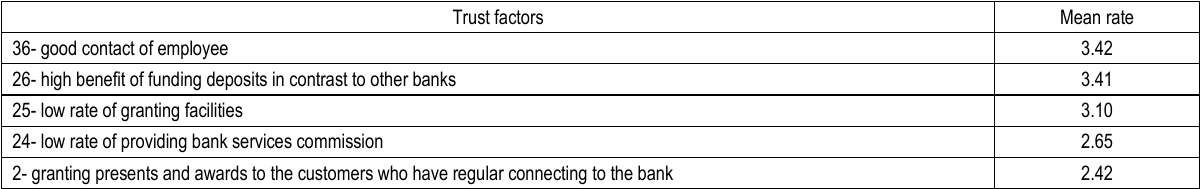
Table 14. Results of mean rate of trust factors based on priority